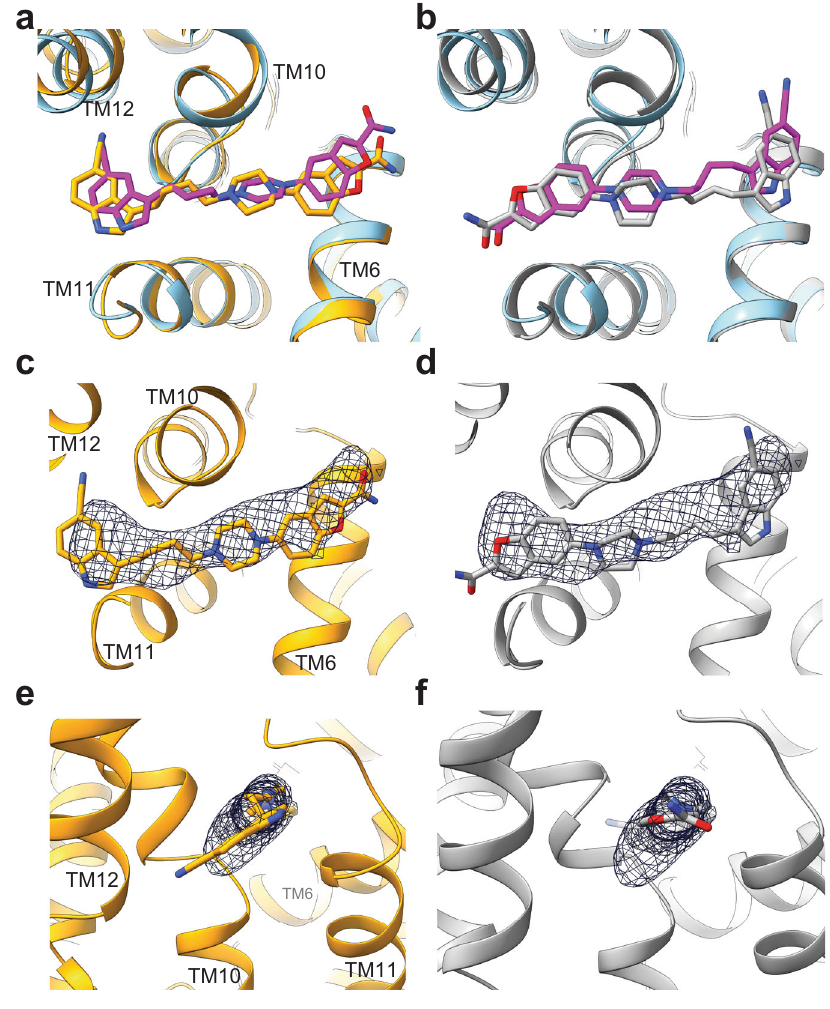
Fig. 5 MD simulations of possible VLZ binding poses. Zoomed view of VLZ modeled into the allosteric binding site of SERT. Parts of SERT TMs and bound IMI are removed for clarity. a The re fi ned cryo-EM SERT structure (blue ribbons) with VLZ (magenta) superimposed onto the fi nal MD simulated SERT structure (orange ribbons) with VLZ (orange) in the hypothezised pose. b Structure of the re fi ned SERT:VLZ complex modeled with the 180° fl ipped VLZ in its binding site and superimposed onto the fi nal MD simulated SERT structure (gray ribbons) with VLZ (gray) in the fl ipped pose. The MD simulations- derived structures of ( c ) SERT with VLZ bound at the hypothesized pose and ( d ) the fl ipped pose, both superimposed on the VLZ electron density from the cryo-EM structure. e , f As in c and d, viewed from the plane of the membrane, showing that the indole ring in the hypothesized pose could explain the density feature in the cryo-EM structure. TM: